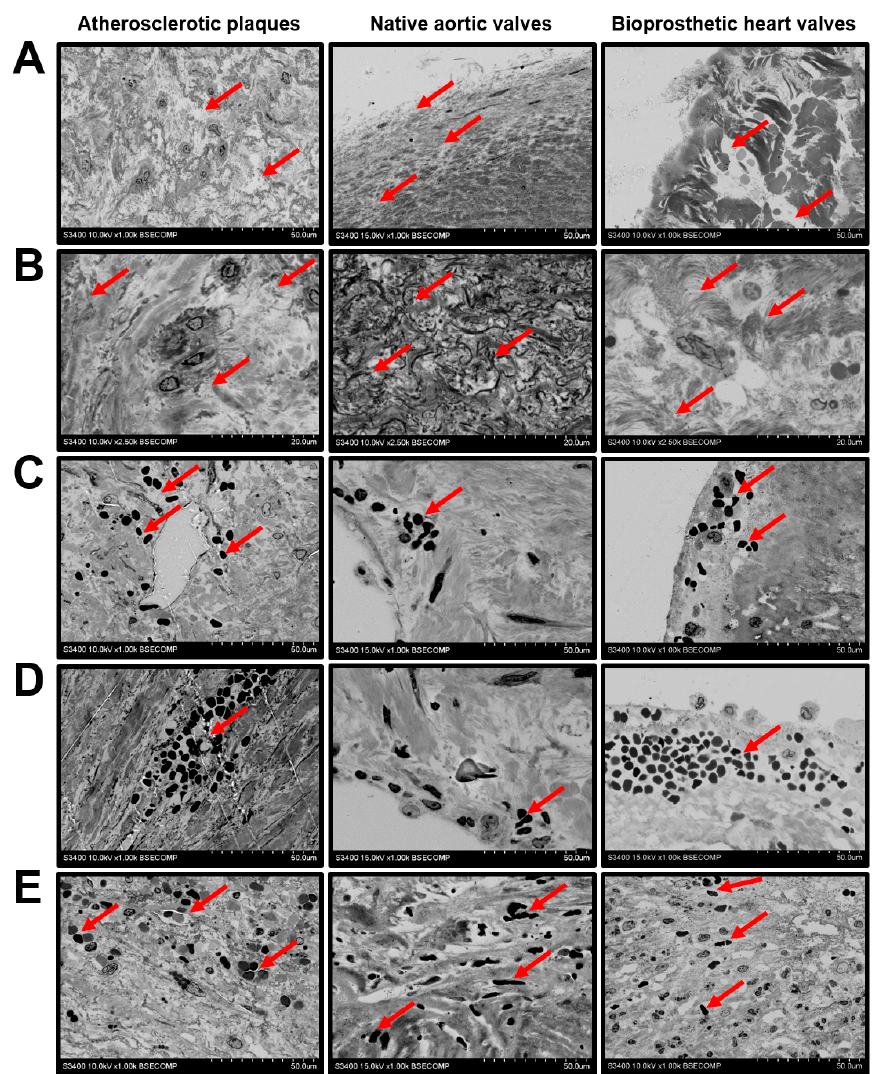
Figure 5. ECM degradation and haemorrhages in atherosclerotic plaques, calcified native AVs, and failed BHVs. ( A ) Loss of the ECM integrity upon the protease- and fatigue-mediated degradation of the ECM components (indicated by red arrows), magnification 1000×. ( B ) Loss of the ECM fiber orientation (indicated by red arrows), magnification 2500×. ( C ) Haemorrhagic infiltration (indicated by red arrows) because of leaky plaque neovessels or the stress-induced penetration of the inflow valve surface, magnification 1000×. ( D ) Delamination of the neointimal and valvular tissue (indicated by red arrows) upon the accumulation of blood in the cavities formed after the ECM degradation, magnification 1000×. ( E ) Haemorrhagic infiltration of deep ECM layers (indicated by red arrows) upon the massive intraplaque or intravalvular bleeding, magnification 1000×.